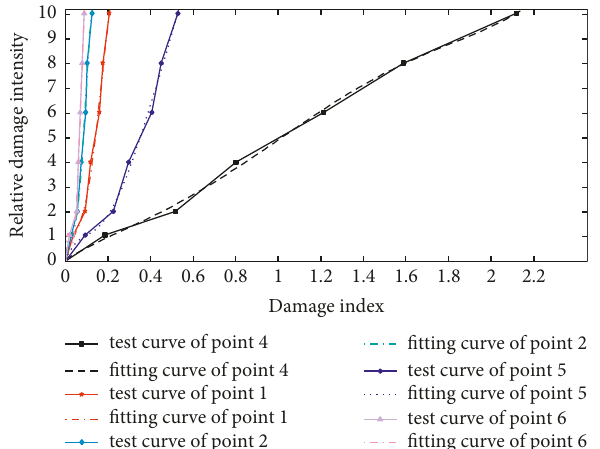
Figure 13: The relationship curves of damage intensity between damage indexes of point 4.